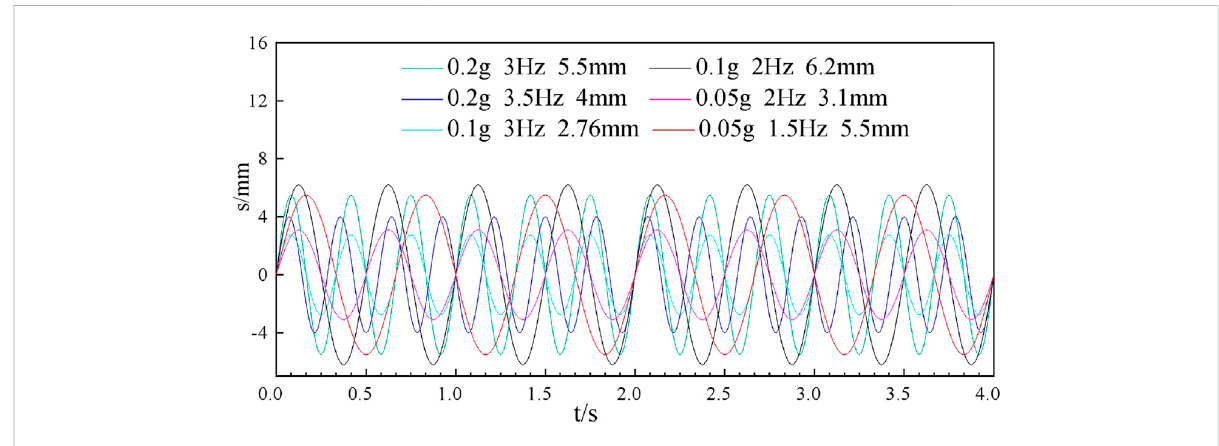
FIGURE 5 Sine form and time-history curve of the seismic